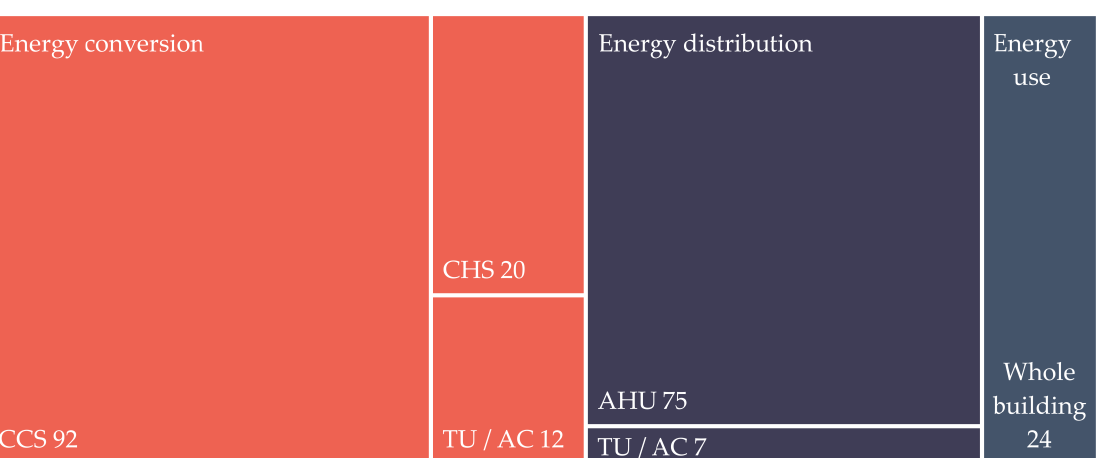
Figure 9. Number of articles within each EST group and building system.